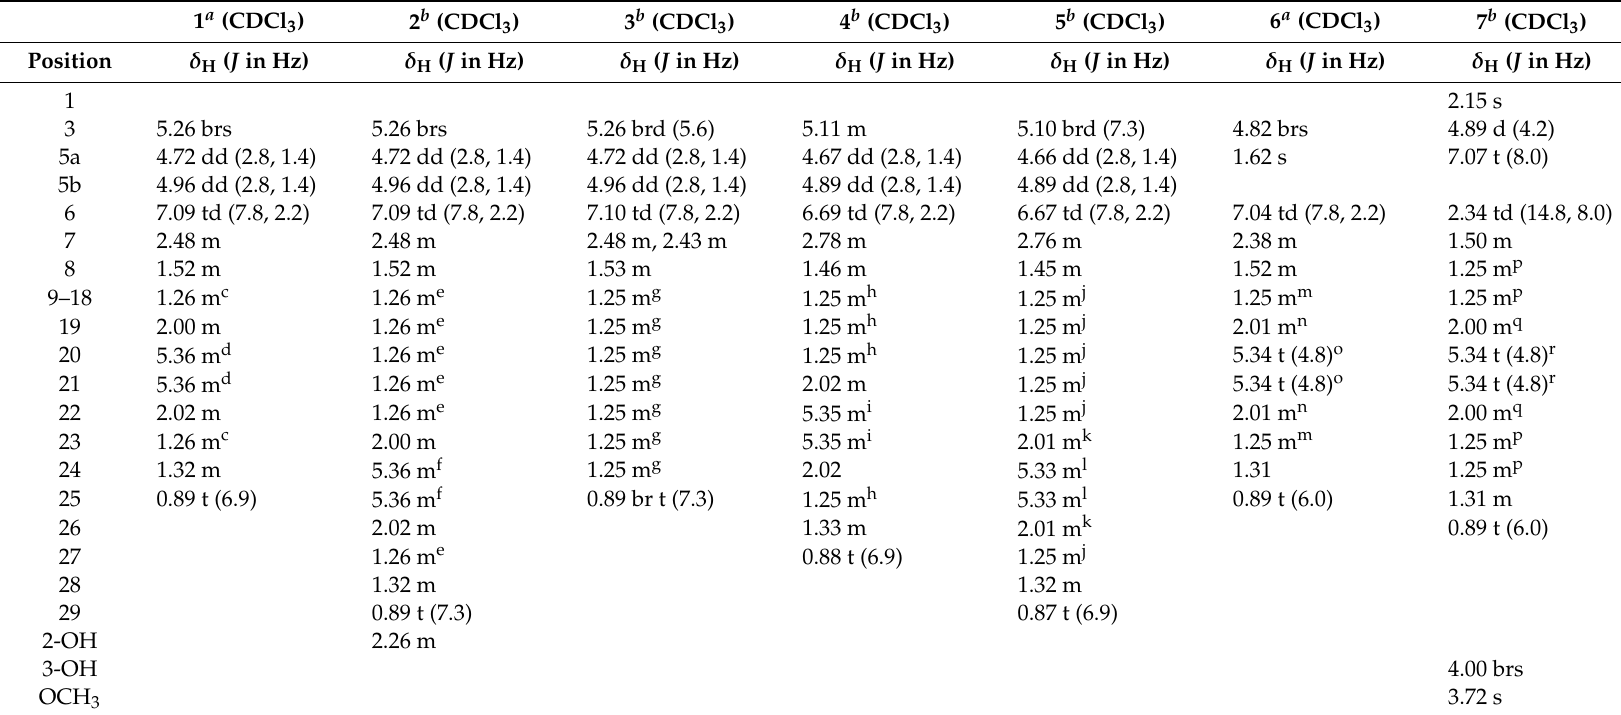
Table 1. 1 H NMR Spectroscopic data of compounds 1 − 7